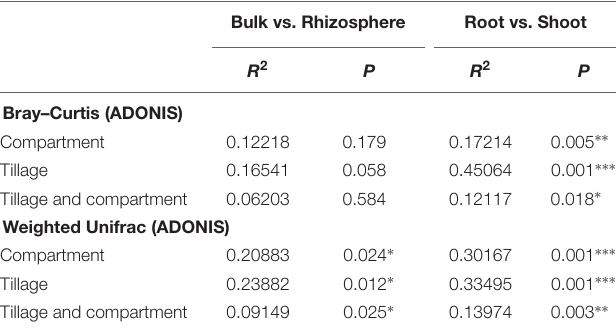
TABLE 2 | Statistical analysis of beta